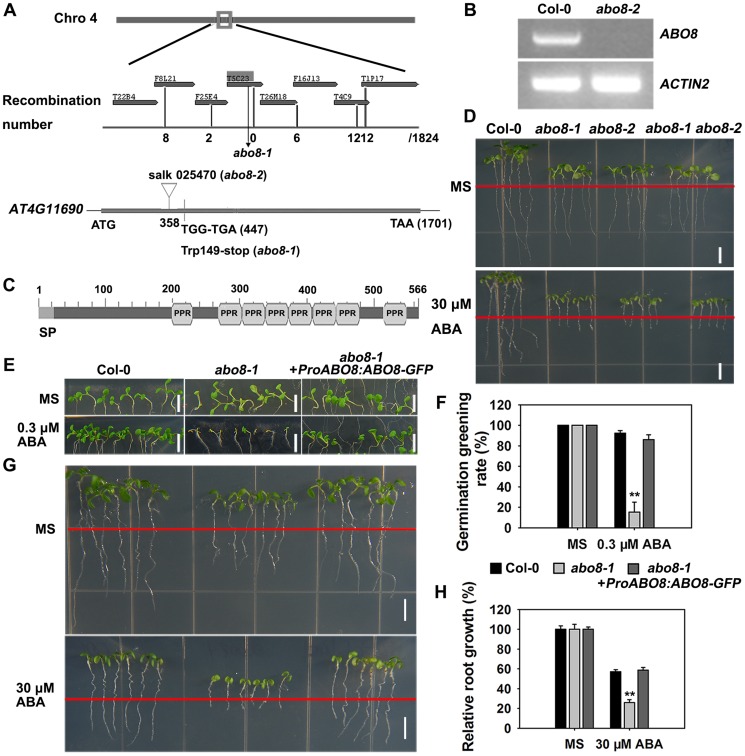
Map-based cloning of ABO8.A. ABO8 was mapped to chromosome 4. A point mutation from G447 to A447 (counting from the first putative ATG in AT4G11690) was identified in abo8-1. A T-DNA insertion line SALK_025470 (abo8-2, T-DNA is inserted in position +358) was obtained from the Arabidopsis Biological Resource Center. B. RT-PCR analysis of ABO8 transcripts in abo8-2 using primers flanking the T-DNA insertion. Expression of the ACTIN2 gene was used as control. C. The protein structure of ABO8. SP: signal peptide; PPR: pentatricopeptide repeat. D. Genetic analysis of abo8-1 and abo8-2 for sensitivity of root growth to ABA. Four-day-old seedlings grown on MS medium were transferred to MS medium containing 0 or 30 µM ABA. abo8-1 abo8-2: F1 seedlings of abo8-1 crossed with abo8-2. Bars = 5 mm. E. Seed germination greening analysis of abo8-1 complemented with an ABO8 promoter driving ABO8 cDNA fused with GFP cDNA (ProABO8:ABO8-GFP) on MS medium containing 0.0 or 0.3 µM ABA. Bars = 5 mm. F. Statistical analysis of seed germination greening rate of the complemented abo8-1 in (E). Three independent experiments were done, each with three replicates (from three different plates). About 24 seeds were counted for each plate. Values are means ±SE, n = 3. **: P<0.01. G. Roots of abo8-1 complemented with ProABO8:ABO8-GFP. Four-day-old seedlings were transferred to MS medium containing 0 or 30 µM ABA. Bars = 5 mm. H. Statistical analysis of root length in (G). Root length is expressed relative to that of the wild type or abo8-1 without ABA. Three independent experiments were done with similar results, each with three biological repeats. Five roots from one plate were measured for each repeat. Values are means ±SE, n = 3. **: P<0.01.